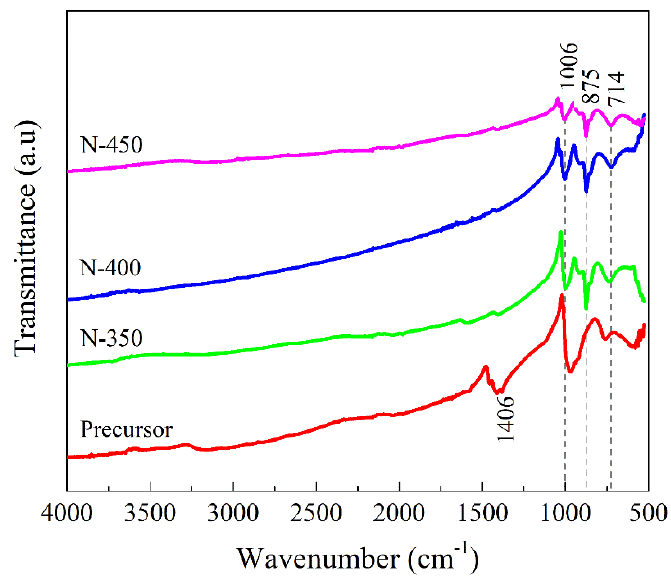
Figure 2. IR spectra of films N − 350, N − 400, and N − 450.